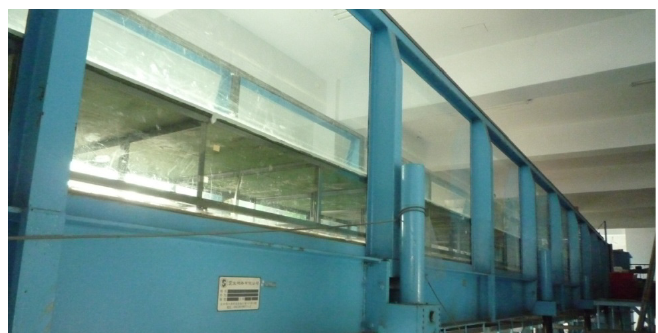
Figure 2. Functional flume.